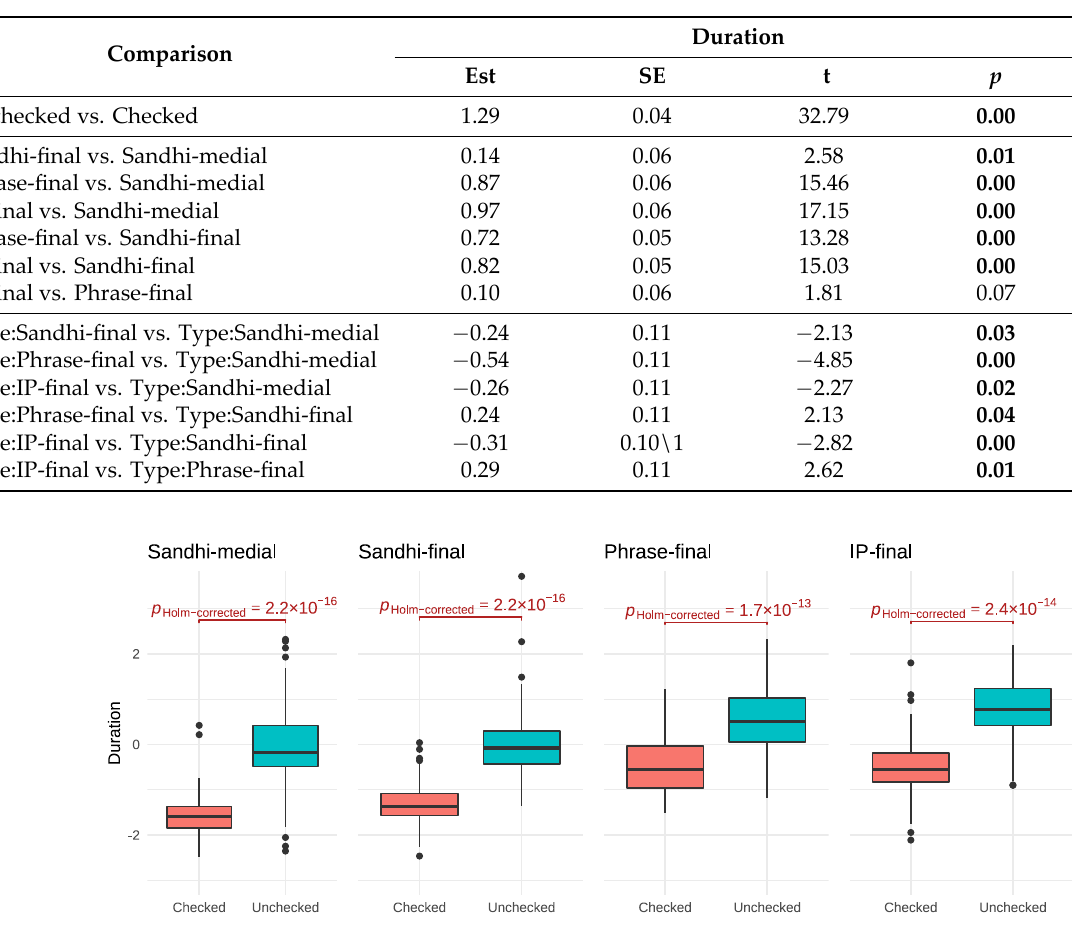
Figure 9. The variation of duration influenced by phonemic type and prosodic position. Significant p ‑values ( p ⩽ 0.05 ) are marked in red, which indicates that the duration difference between checked and unchecked syllables is significant in that prosodic